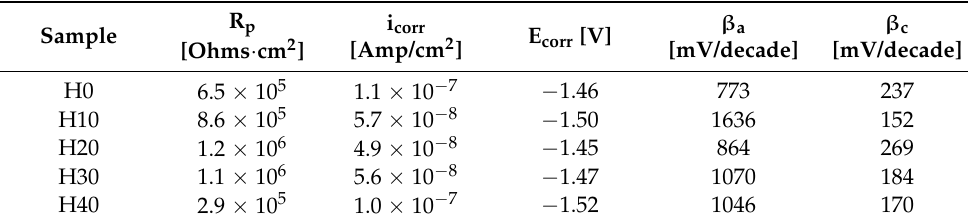
Figure 10. Polarization curves for the studied samples. Table 4. Corrosion properties of studied samples. Table 4. Corrosion properties of studied